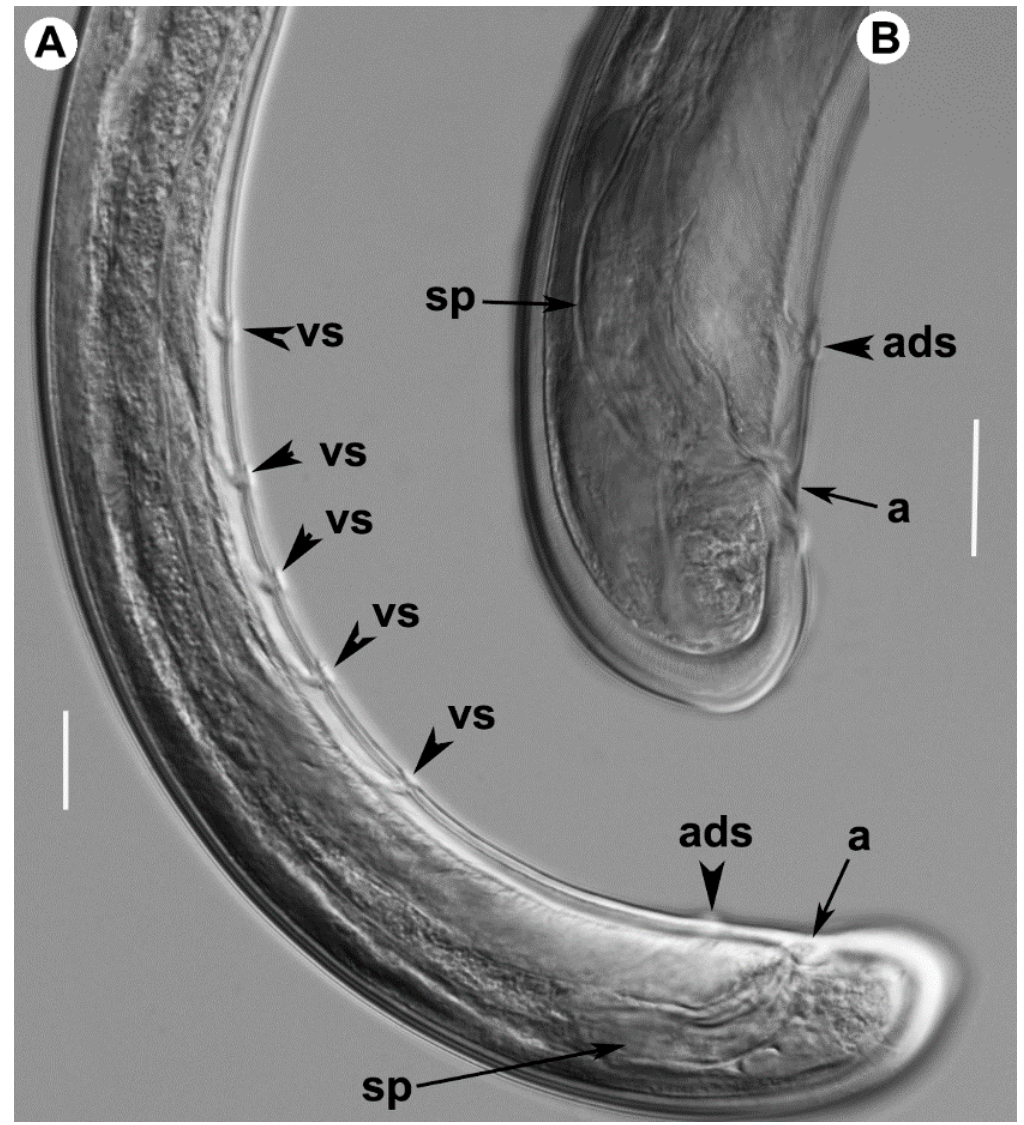
Figure 9. Light photomicrographs of Xiphinema malaka sp. nov. male: ( A ), posterior region; ( B ), detail of tail showing spicules. Abbreviations: a = anus; ads = adanal supplements; sp = spicules; vs = ventromedian supplements. Scale bars: 20 μ m.